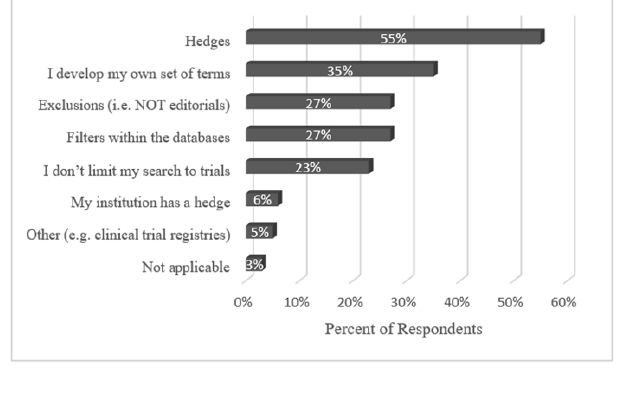
Figure 2 Methods for search string development